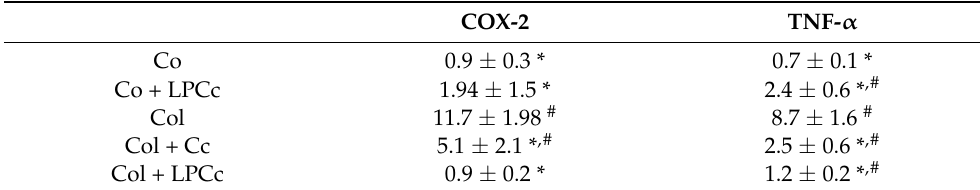
Table 3. Expression of the positive pixels as the mean ± SD obtained for each colon tissue. Co: control; Co + LPCc: control + LPC cookie; Col: colitis; Col + Cc: colitis + control cookie; Col + LPCc: colitis + LPC cookie. * represents p < 0.001 when compared to colitis and # p < 0.05 when compared to control.